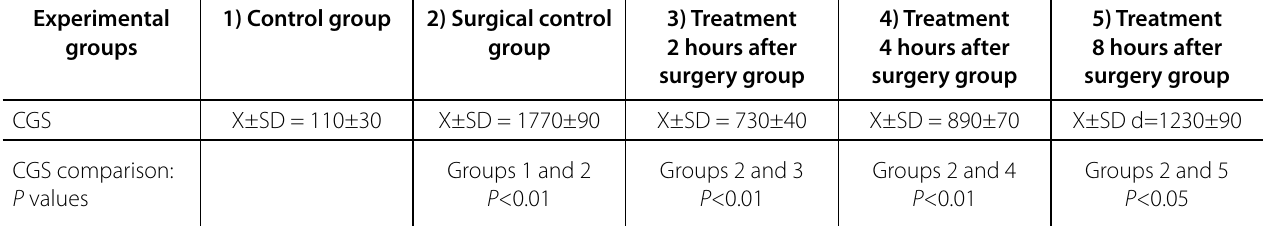
Table 1 . Consolidated gravity scores (CGS) comparisons between different experimental